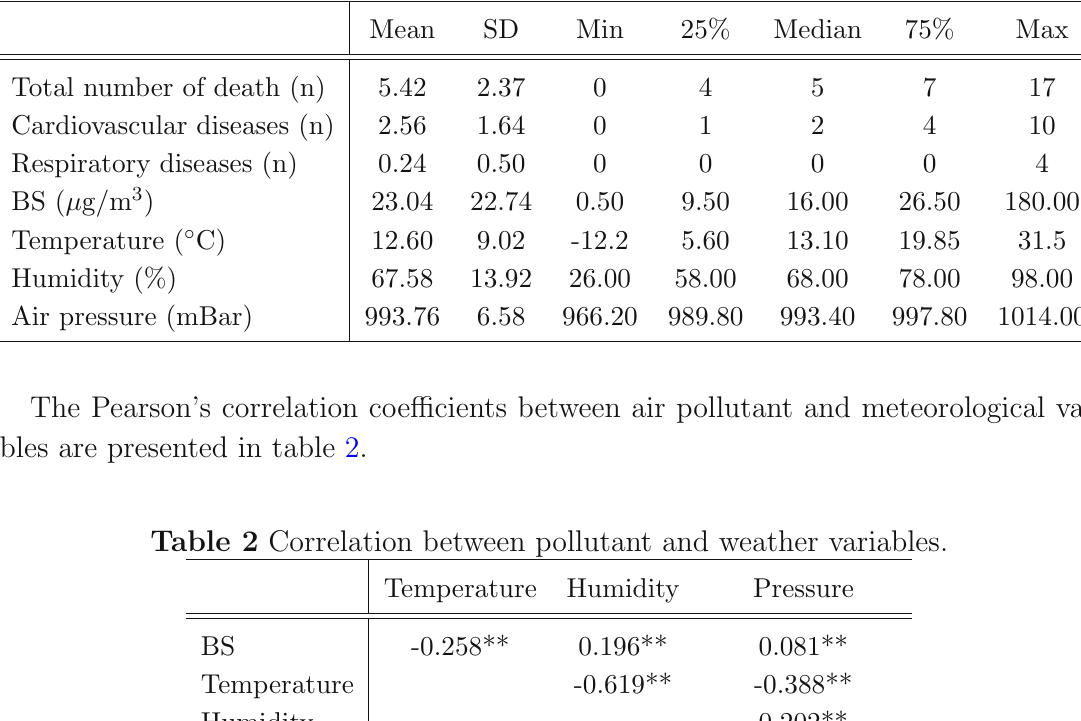
Table 1 Summary